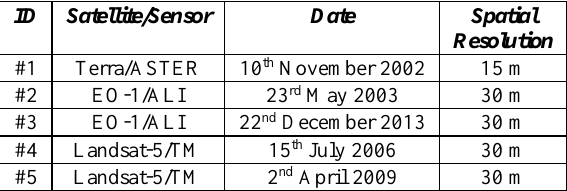
Table 2. The multi-source data set available for the case